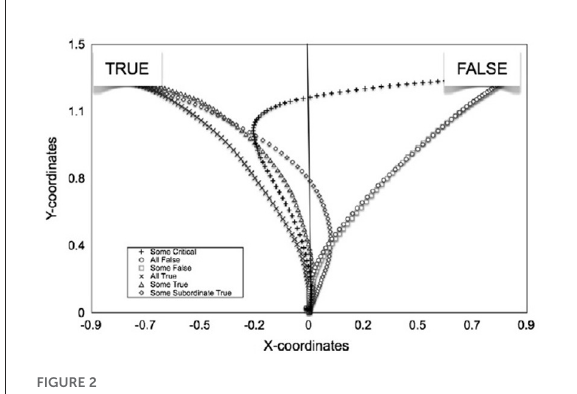
FIGURE2 A sample display of average mouse trajectories in Experiment 2 in Tomlinson et al. (2013), where the diagonal crosses to FALSE correspond to pragmatic interpretations and the vertical crosses to TRUE correspond to logical